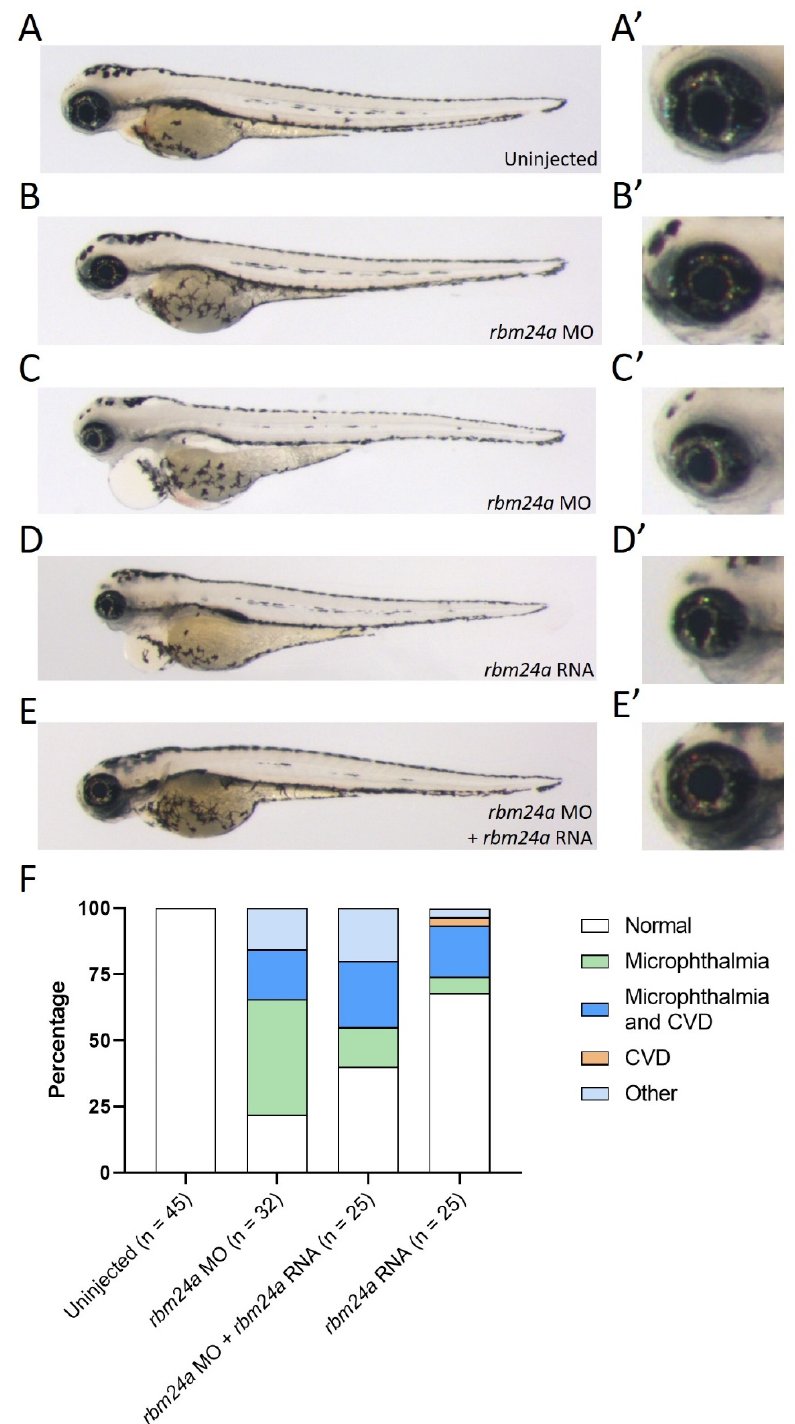
Figure 2. Suppression of rbm24a morpholino knockdown with rbm24a RNA. ( A ) Uninjected 4 dpf embryo with wild type morphology, ( A’ ) detail of eye in A. ( B ) Knockdown of rbm24a at low doses leads to microphthalmia, ( B’ ) detail of eye in B, while ( C ) is a higher dose showing microphthalmia with cardiac edema, ( C’ ) detail of eye in C. ( D ) Injection of rbm24a RNA yields phenotypes similar to higher dose knockdown, ( D’ ) detail of eye in D. ( E ) Sequential injection of rbm24a morpholino and rbm24a RNA suppresses the phenotypes, ( E’ ) detail of eye in E. ( F ) Graph of phenotypes. Images taken at 33×.